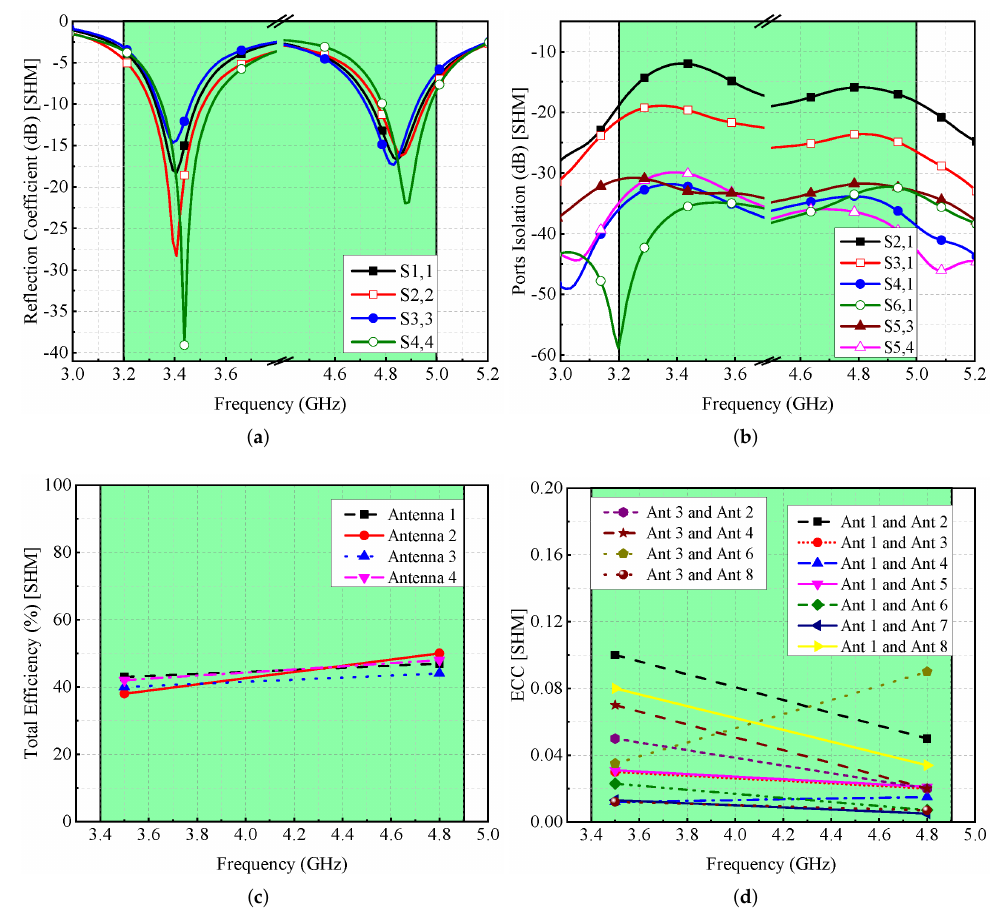
Figure 14. Effect of single-hand on MIMO antenna’s (a) reflection coefficient, (b) isolation, (c) efficiency, and (d) ECC. Table 2. Comparative analysis among previously presented and proposed MIMO antennas.